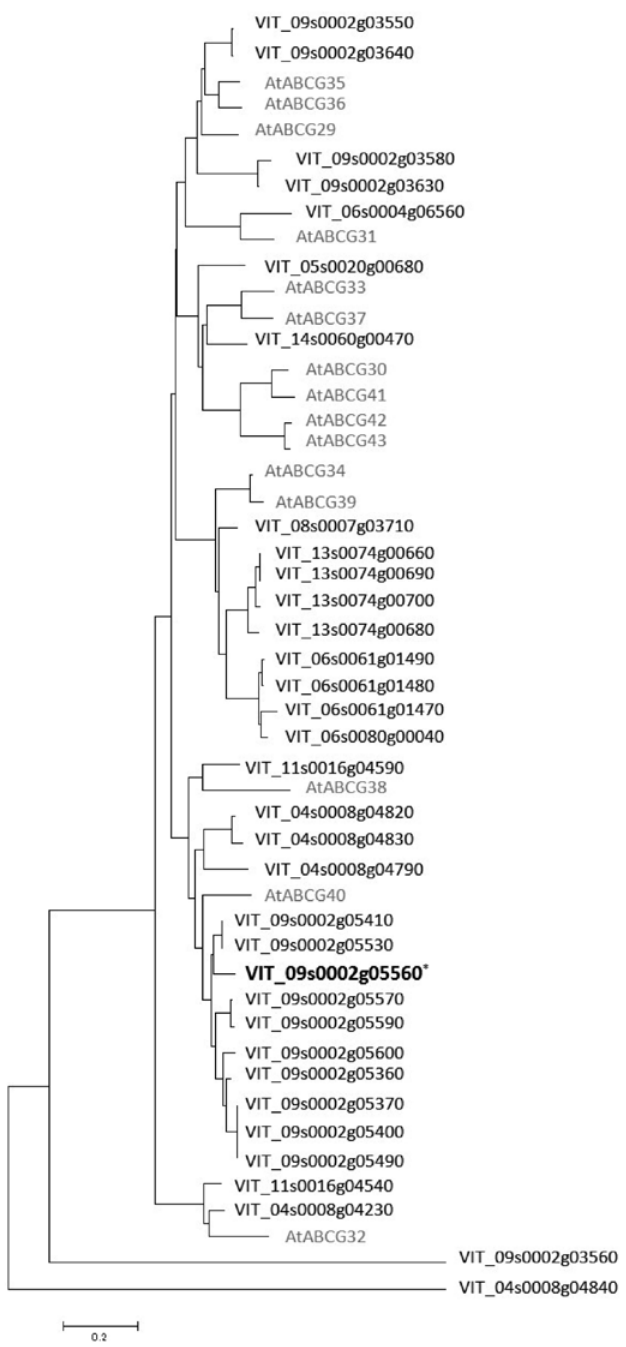
Fig. 6 - Phylogenetic tree of all full-size ABCGs in Arabidopsis and VvABCG44. A neighbor-joining tree was constructed with MEGA5 (Tamura et al .,